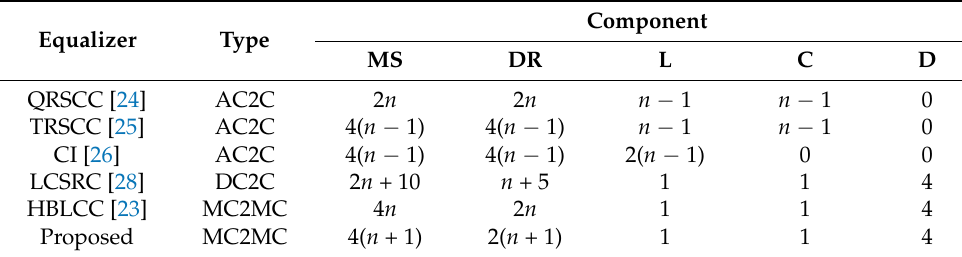
Table 4. Component comparison of equalizers for n cells/modules.